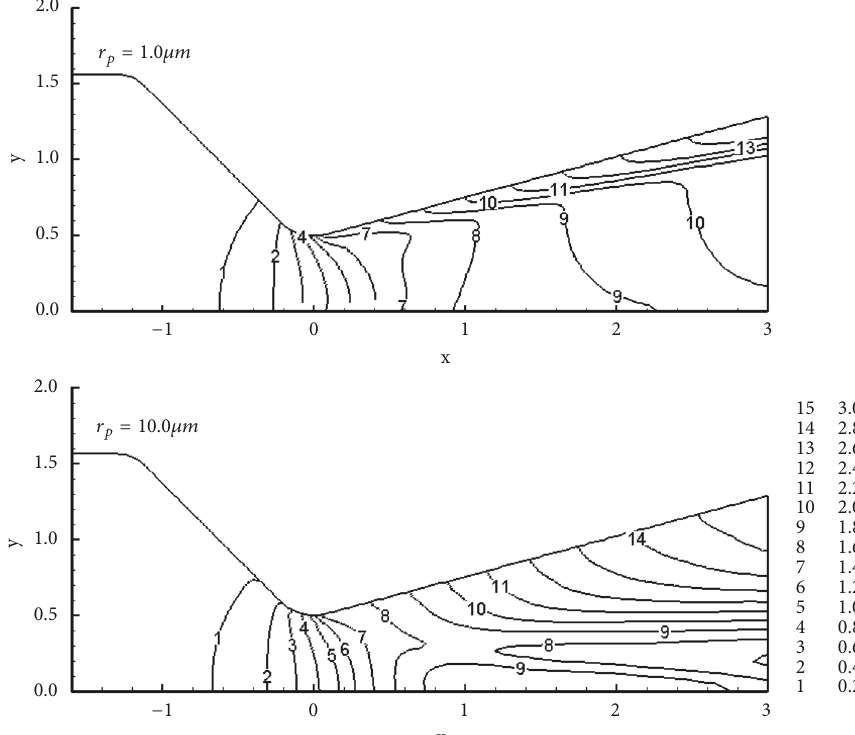
Figure 5: Mach number distribution of two-phase flow field.